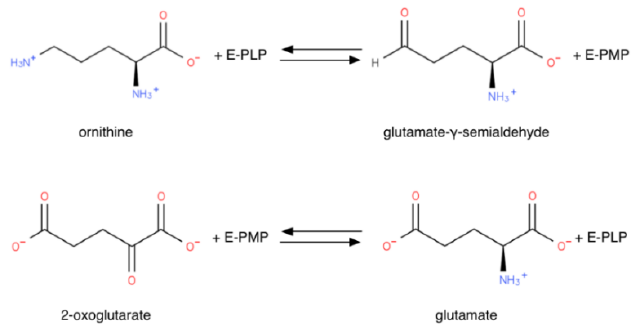
Figure 4. “Ping-pong” mechanism half-reactions of OAT (E-PLP: OAT PLP adduct; E-PMP: OAT PMP adduct).